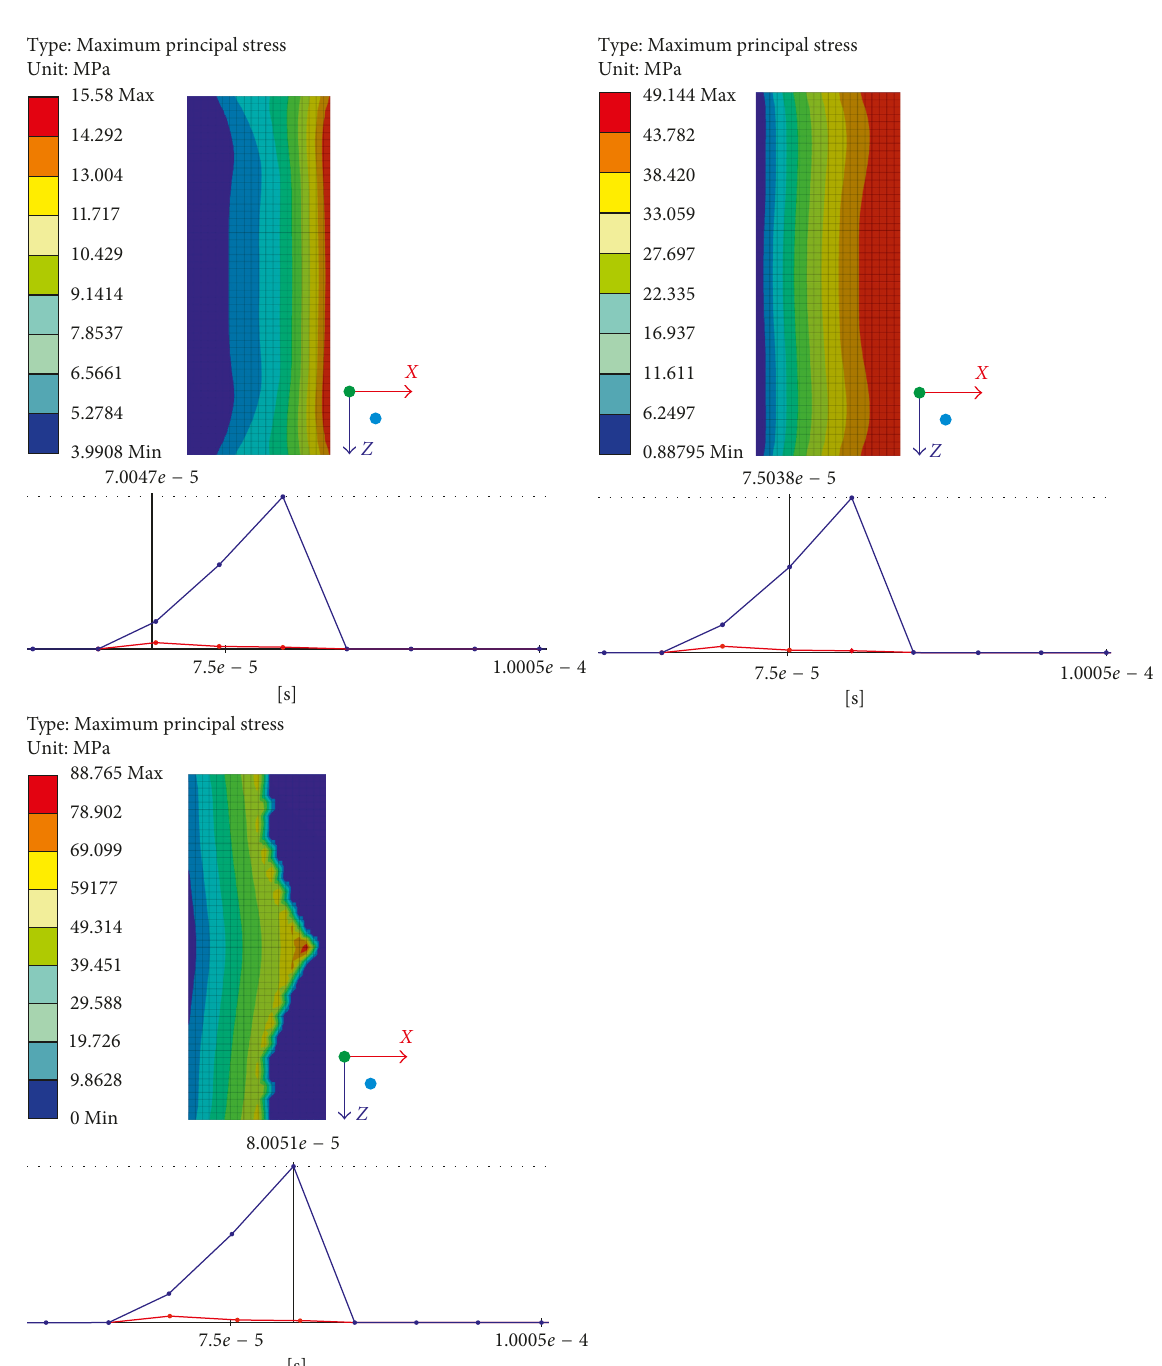
Figure 15: Changes in Max Principal Stress distributions in time, during dynamic impact loading of the block sample with declared adhesive tensile strength of 80